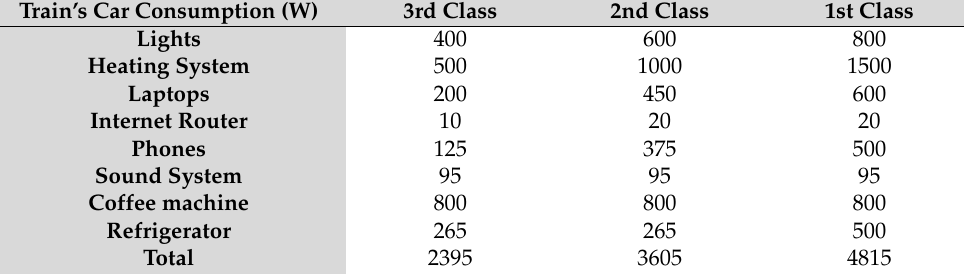
Table 3. Electrical appliance’s power consumption according to the ticket class. Train’s Car Consumption